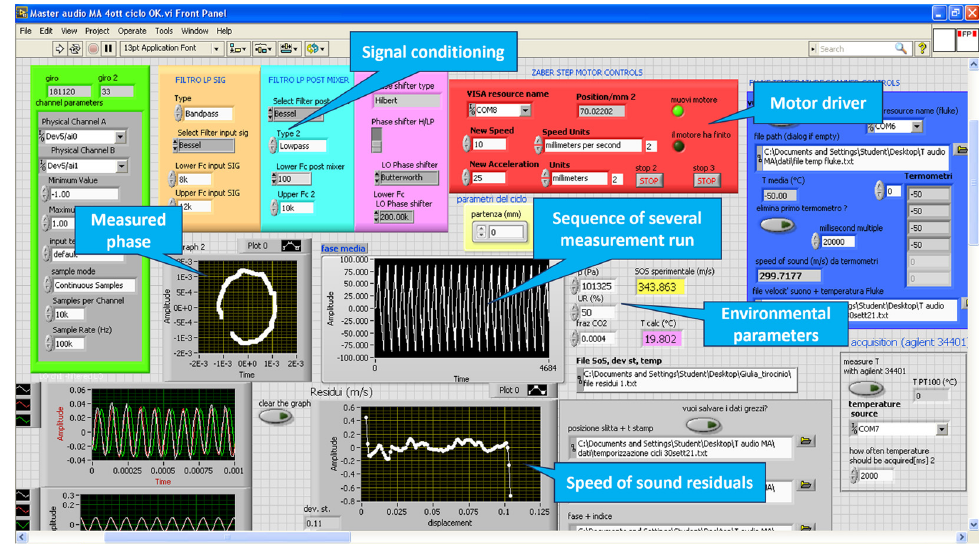
Figure 3. Screenshot of the LabVIEW software. Some of the key functions are indicated in the callouts. For each cycle, the measurement of the phase is recorded and the slope of the function phase/displacement is calculated. The lower graph shows the residuals of the function with respect to the linear fit. This gives an indication of the quality of each single measurement.